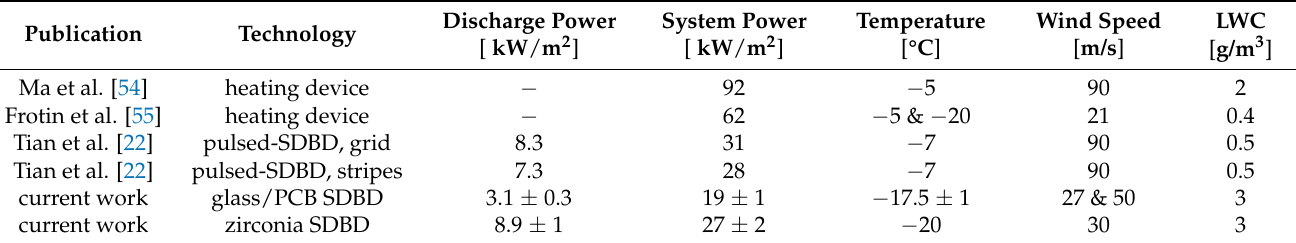
Table 2. Comparison of the power consumption for different anti-icing technologies. The discharge power is the power consumption obtained from the QV-plots which is only applicable for the SDBDs. The system power includes the power required to generate the high voltage. The last there columns present the parameters of the iCORE. The temperature of the supercooled droplets, ice wind speed and the liquid water content